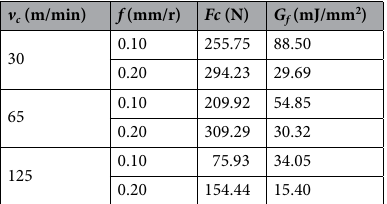
Table 8. Cutting parameters for dry turning